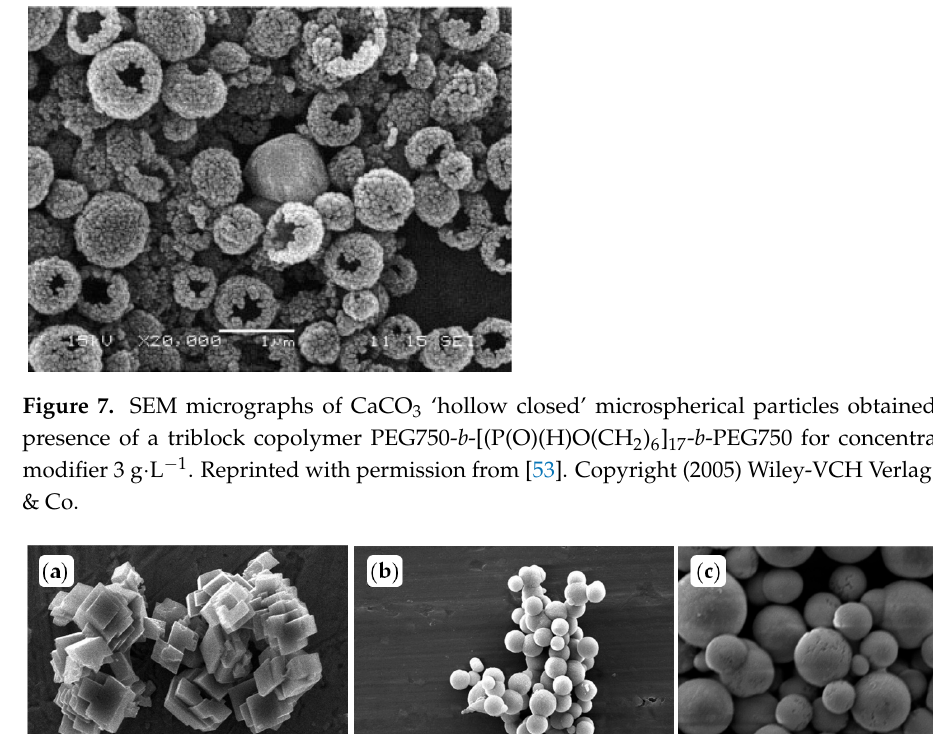
Figure 8. SEM images of CaCO 3 particles obtained ( a ) in the absence of polymeric modifier; ( b ) in the presence of Na-PEP; ( c ) in the presence of phosphorylated glycerol. Magnification 5000 × . Reprinted with permission from [40]. Copyright (2009) Taylor & Francis Group, LLC.